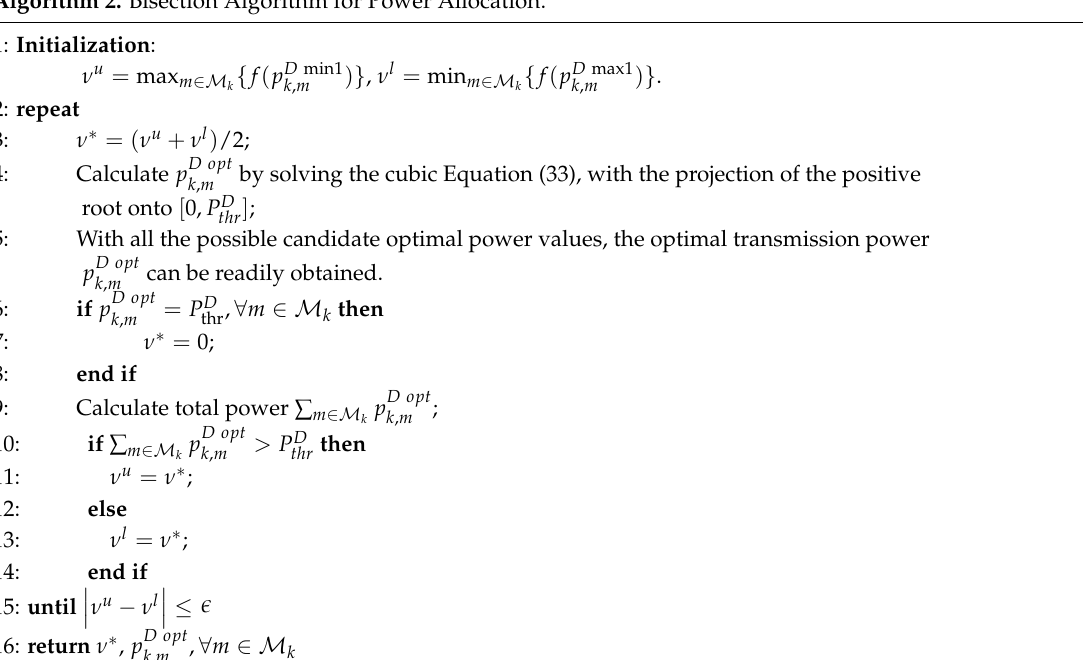
Algorithm 2. Bisection Algorithm for Power Allocation.